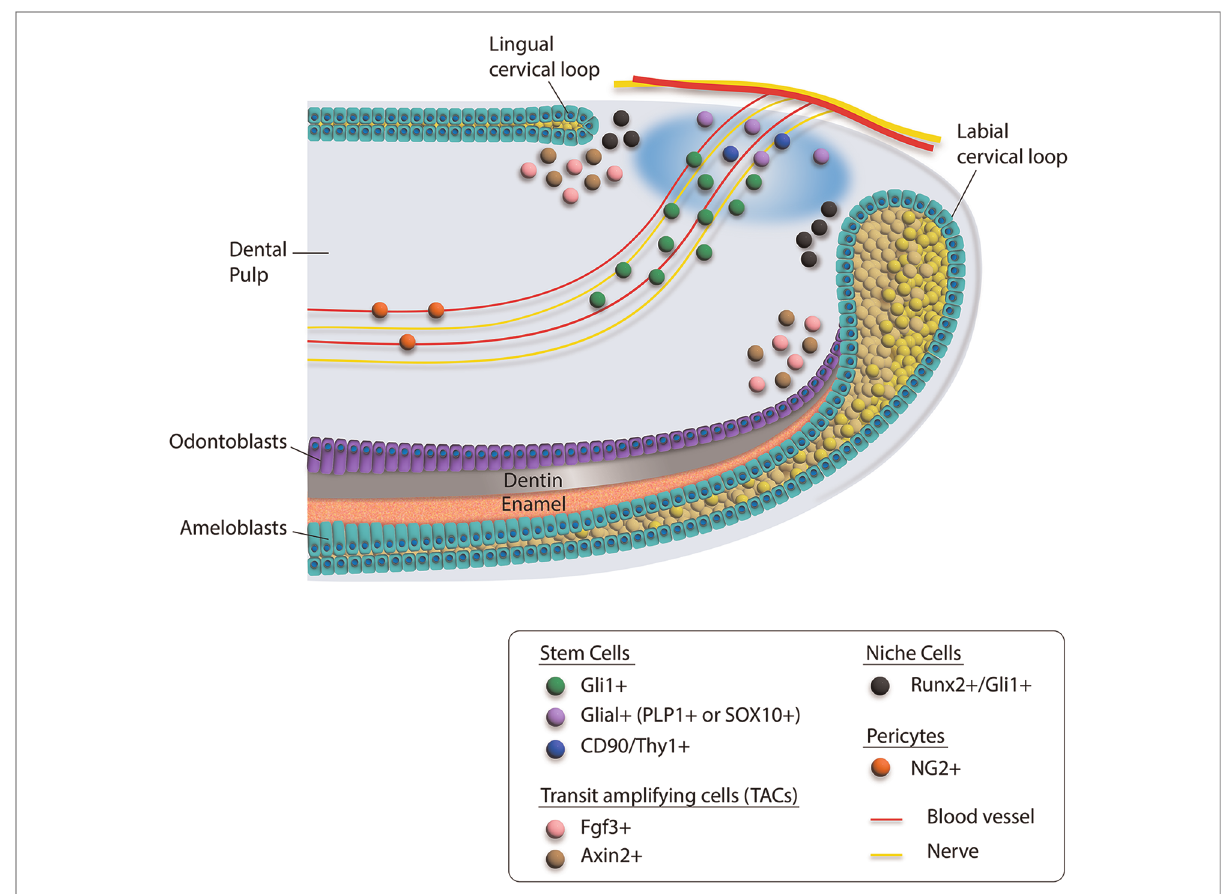
FIGURE 1 Schematic diagram of heterogeneity of cells in the proximal region of the mouse incisor. Different cell types are indicated by colored dots. Mesenchymal stem cells including Gli1+, Glial+, and CD90/Thy1+cells are located around the neurovascular bundle, while Runx2+/Gli1+niche cells are adjacent to the cervical loop. The transit amplifying cells are indicated by Fgf3+and